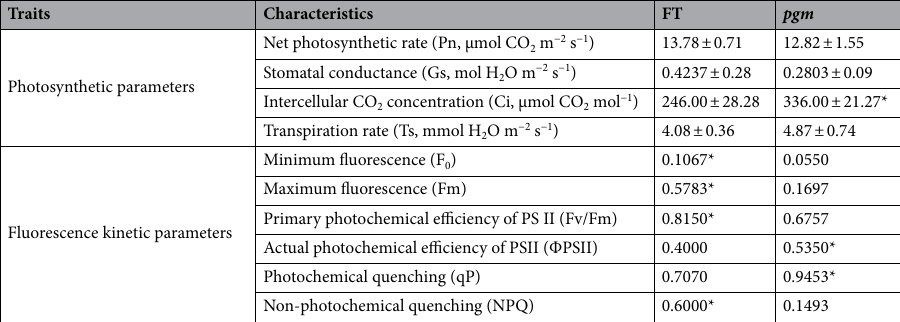
Table 2. Photosynthetic parameters and fluorescence kinetic parameters of leaves in pale green mutant ( pgm ) and wild-type (FT). The t-test with paired comparison was used to test the significant differences between the wild-type FT and pale green mutant ( pgm ).The ‘*’ followed by figures represents significant differences at 5% levels.